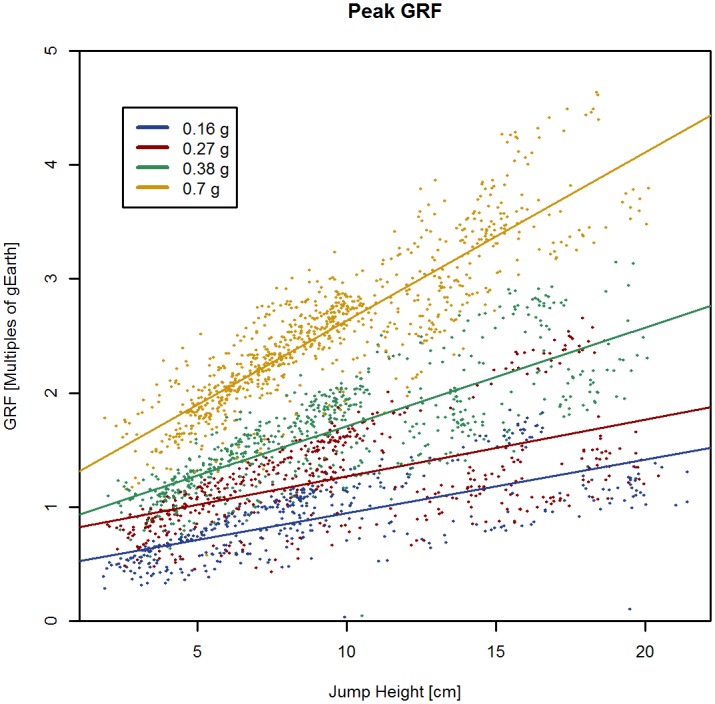
Hopping peak reaction forces (peak vertical GRF).Composite peak vertical GRF signals of all hopping trials are depicted. Ground Reaction Forces (GRF) are expressed as multiples of Earth’s gravity (1g). Peak vertical GRF increased significantly with increasing gravity levels and increasing jump heights (height of flight; P < 0.001).